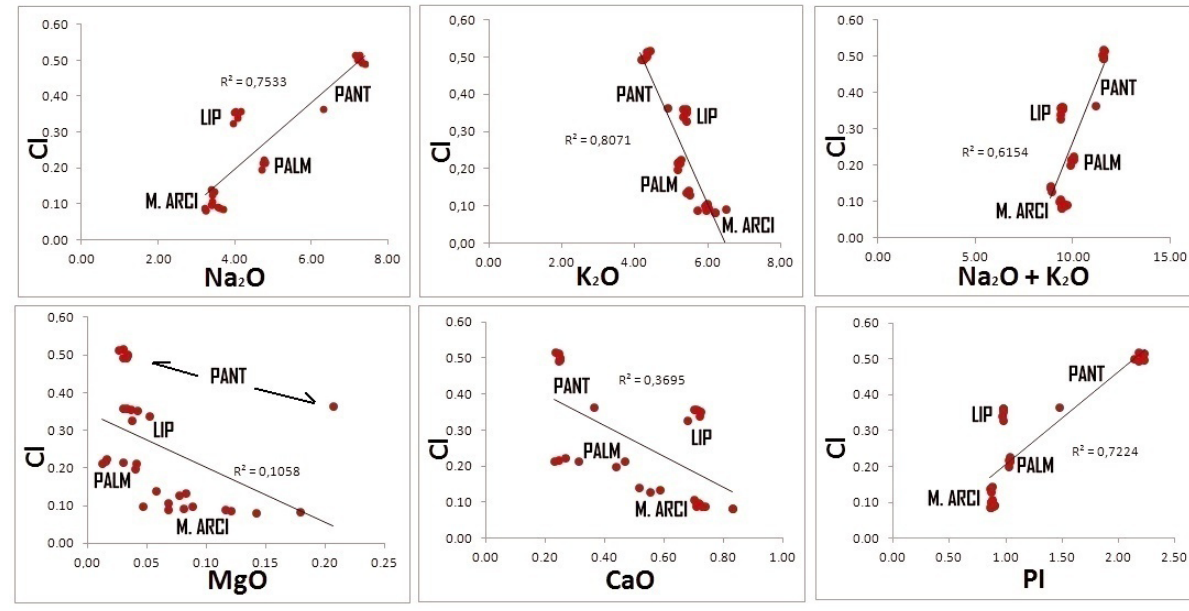
O+K O) and peralkalinity 2 2